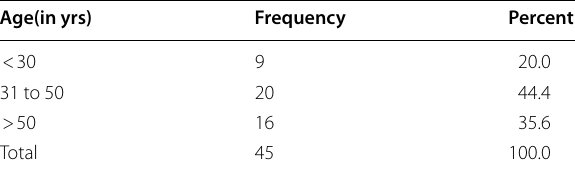
Table 1 Age-wise distribution of subjects